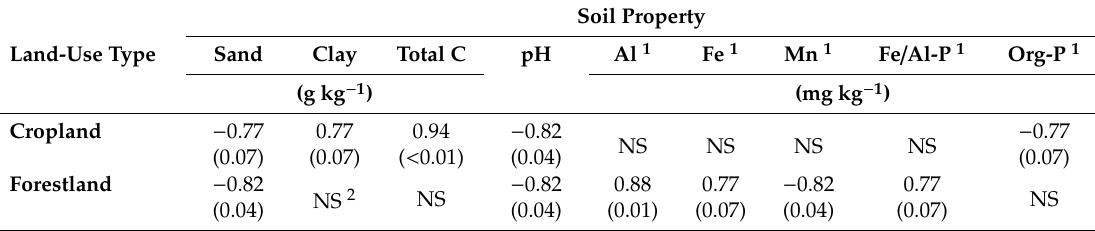
Table 2. Pearson correlation coe ffi cients ( r ) and p values (in brackets) for correlation analysis between P sorption index (P 150 ) and some soil properties in the 0–10 cm layer of cropland and forestland in shelterbelt systems ( n = 6).